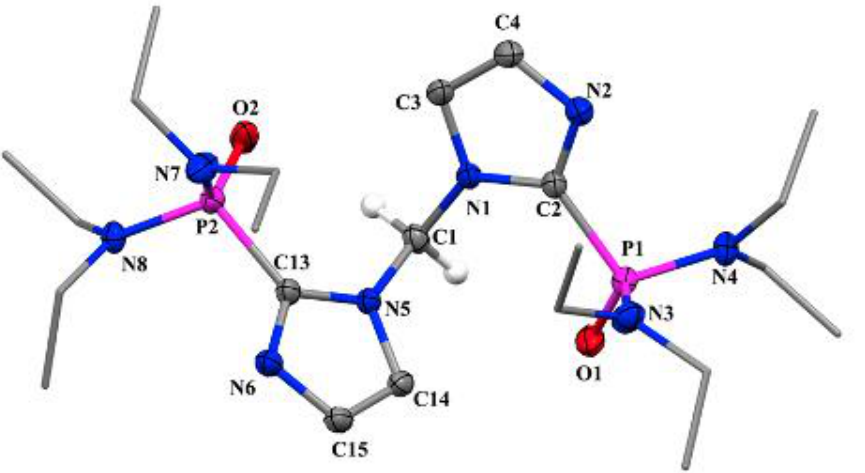
Figure 2. Molecular structure of 2 . All hydrogen atoms except CH and lattice acetonitrile are omitted for clarity. Displacement ellipsoids are drawn at the 30% probability level. Selected bond lengths